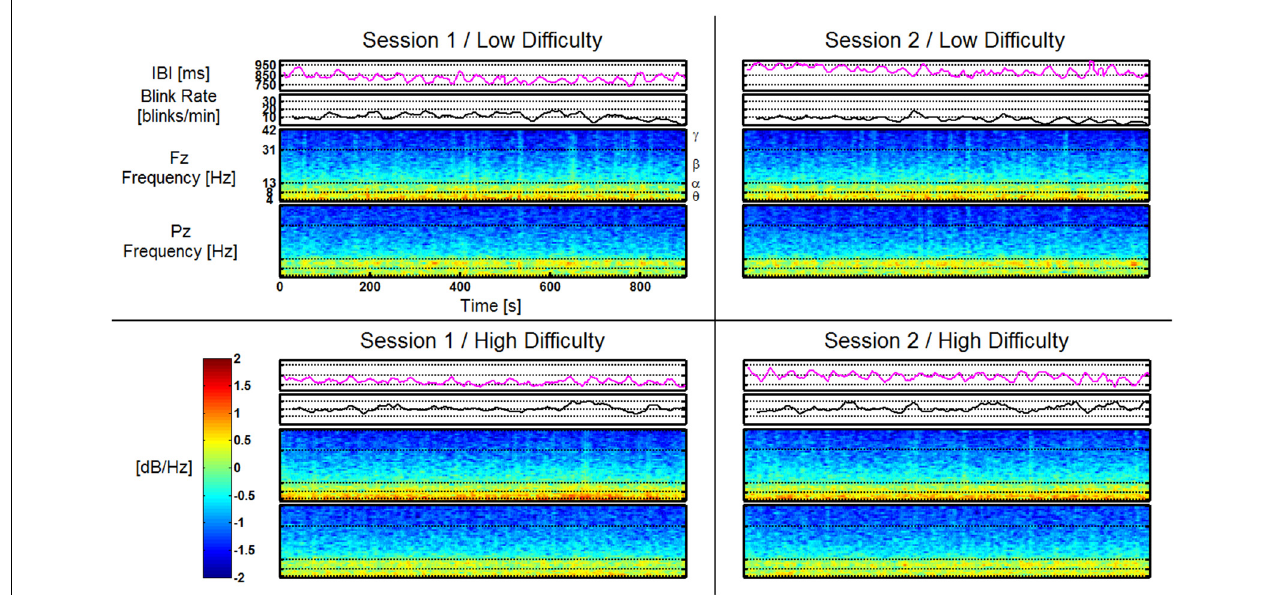
FIGURE 11 | Feature plots for IBI, Blink Rate, Fz, and Pz (shown as time-frequency plots) for a participant in the Replaced group. Feature plots for this participant are shown, respective of task difficulty (in rows) and session (in columns). All corresponding feature plots are shown on the same y-axis scale (e.g., all time-frequency plots for Fz and Pz are shown using the